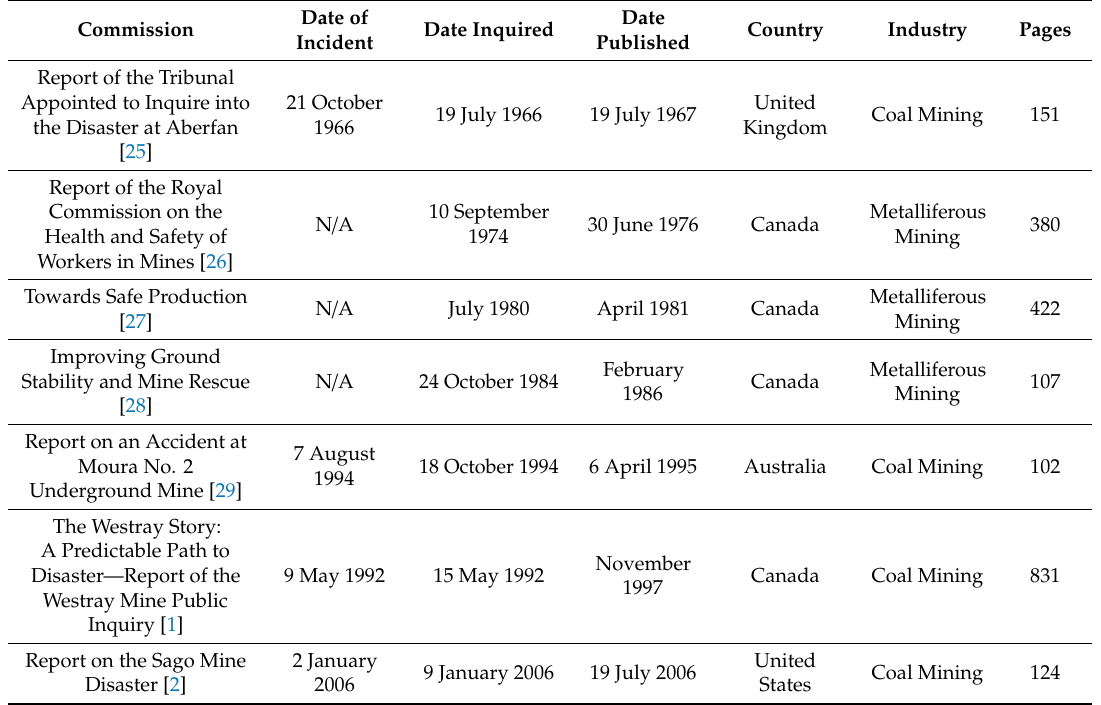
Table 1. Occupational health and safety commission